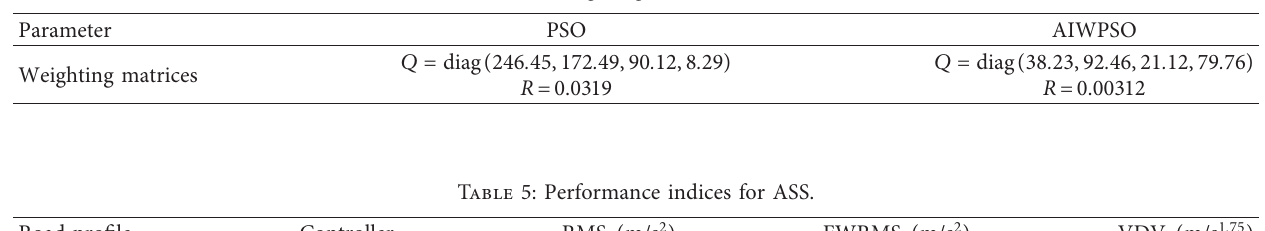
Table 4: Weighting matrices of LQR.